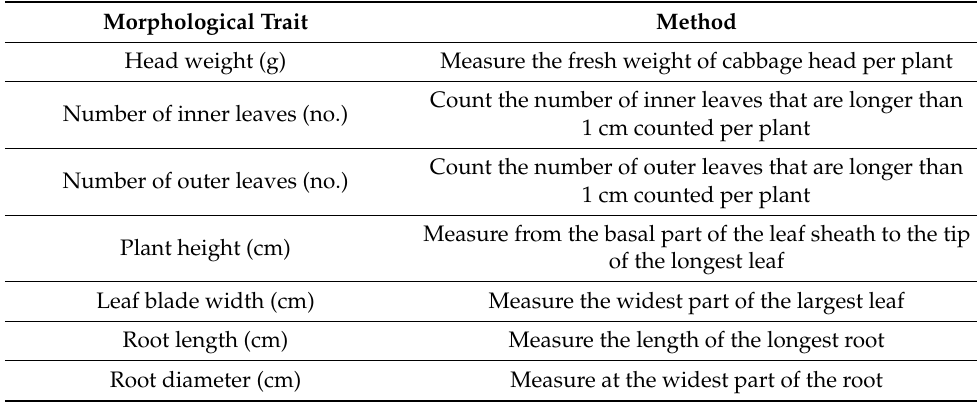
Table 1. Morphological traits and measurement methods used in this study. Morphological Trait Method Head weight (g)